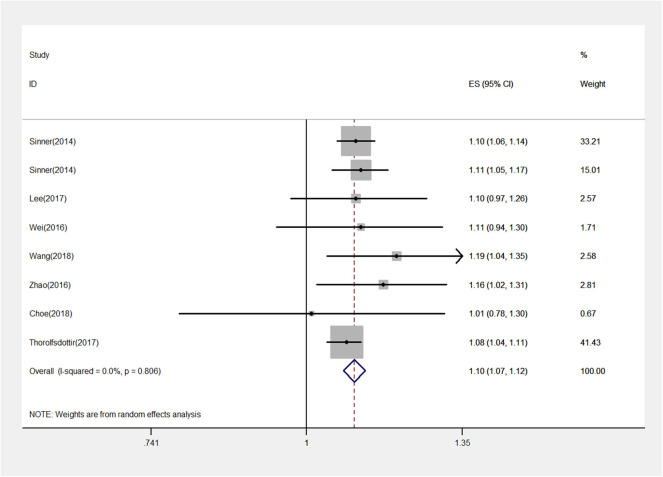
Forest plot for the rs13216675 and risk of atrial fibrillation (AF) using an additive model. The squares and horizontal lines correspond to the study-specific odds ratio (OR) and 95% confidence interval (CI), respectively. The area of the squares reflects the weight (inverse of the variance). The diamond represents the OR and 95% CI of the pooled results.